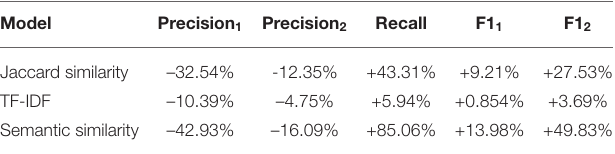
TABLE 3 | The influence of different similarity measurements on performance.